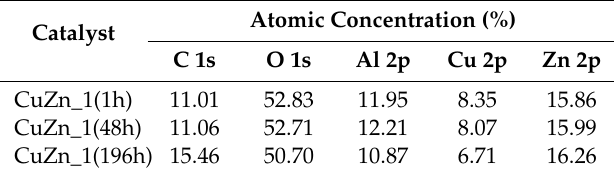
Table 7. Surface atomic concentration of CuZn_1 catalysts synthesized with di ff erent aging